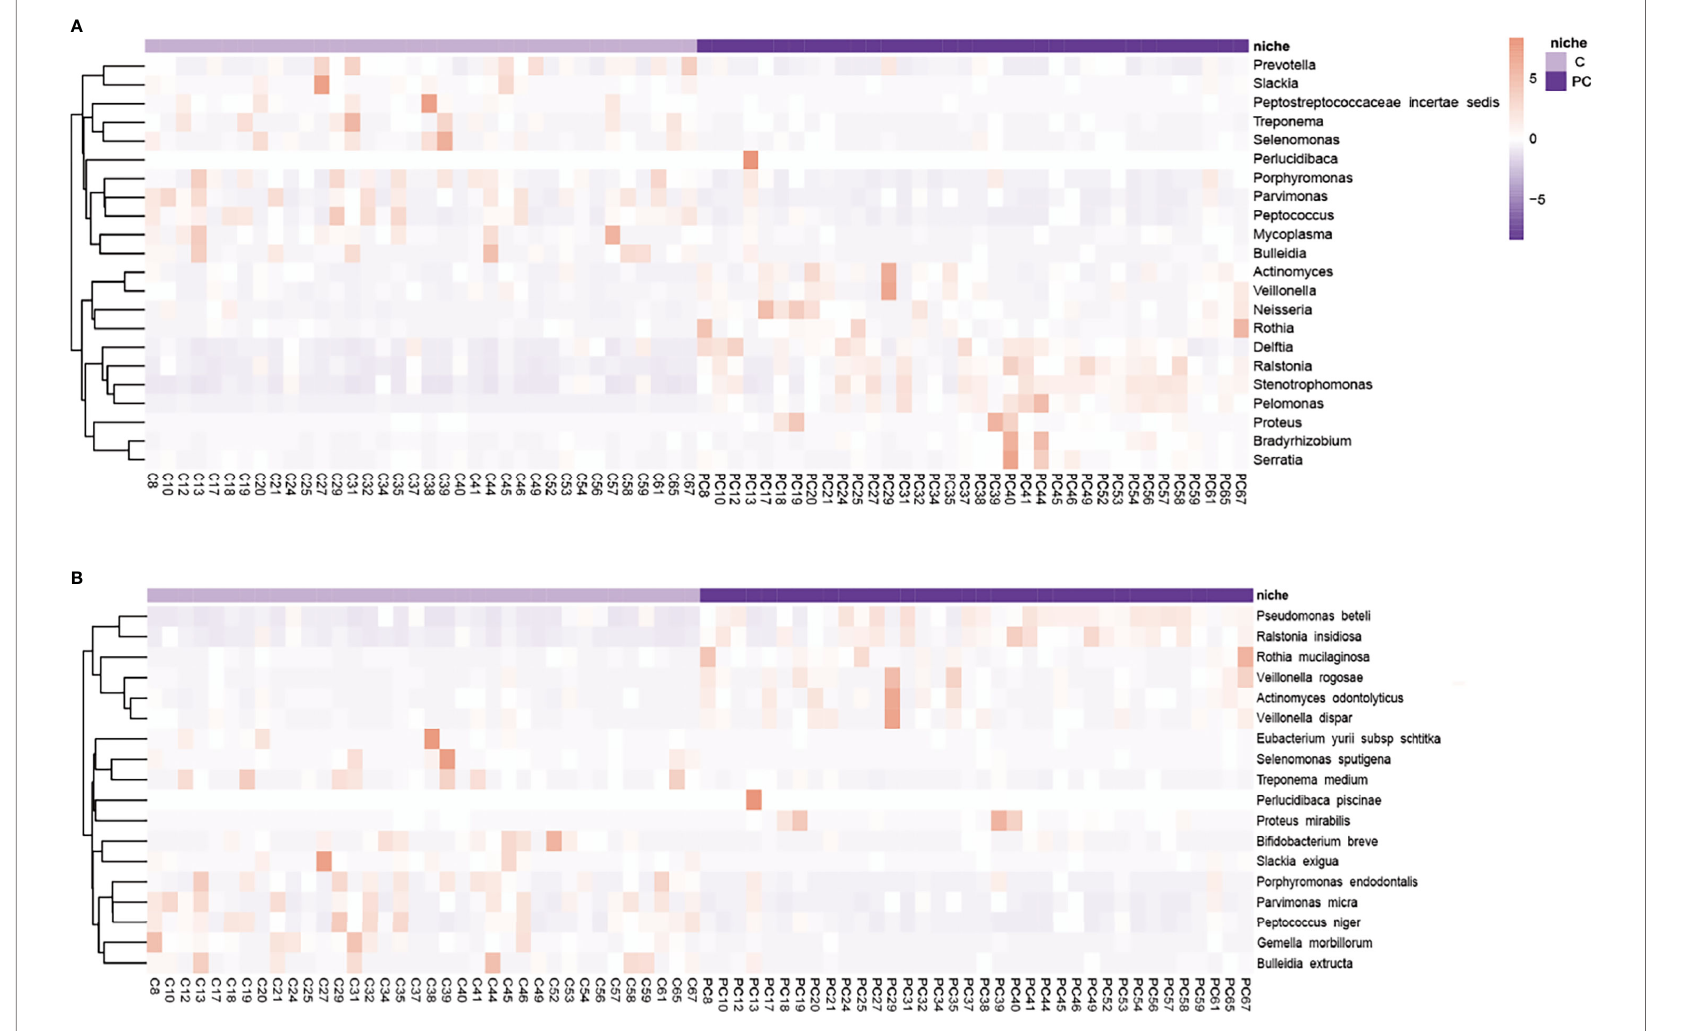
FIGURE 3 | Hierarchically clustered heatmap analysis of differential micro fl ora. The (A) genera and (B) species level microbial community indicated the formation of two main clusters, separating tumor tissue and paracancerous tissue of each subject. Color key of heat map was shown on the right side of the fi gure. It shows microbes with high abundance in red, microbes with low abundance in purple. C, tumor tissue; PC, paracancerous